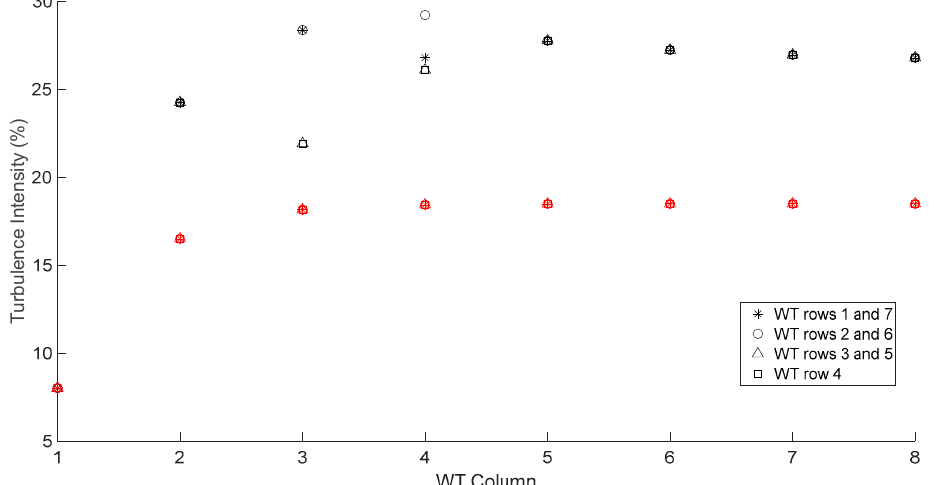
Figure 7. Turbulence intensity in the inflow of each wind turbine using the classic pitching strategy (markers in red) and the optimised pitching strategy proposed in this paper (markers in black).